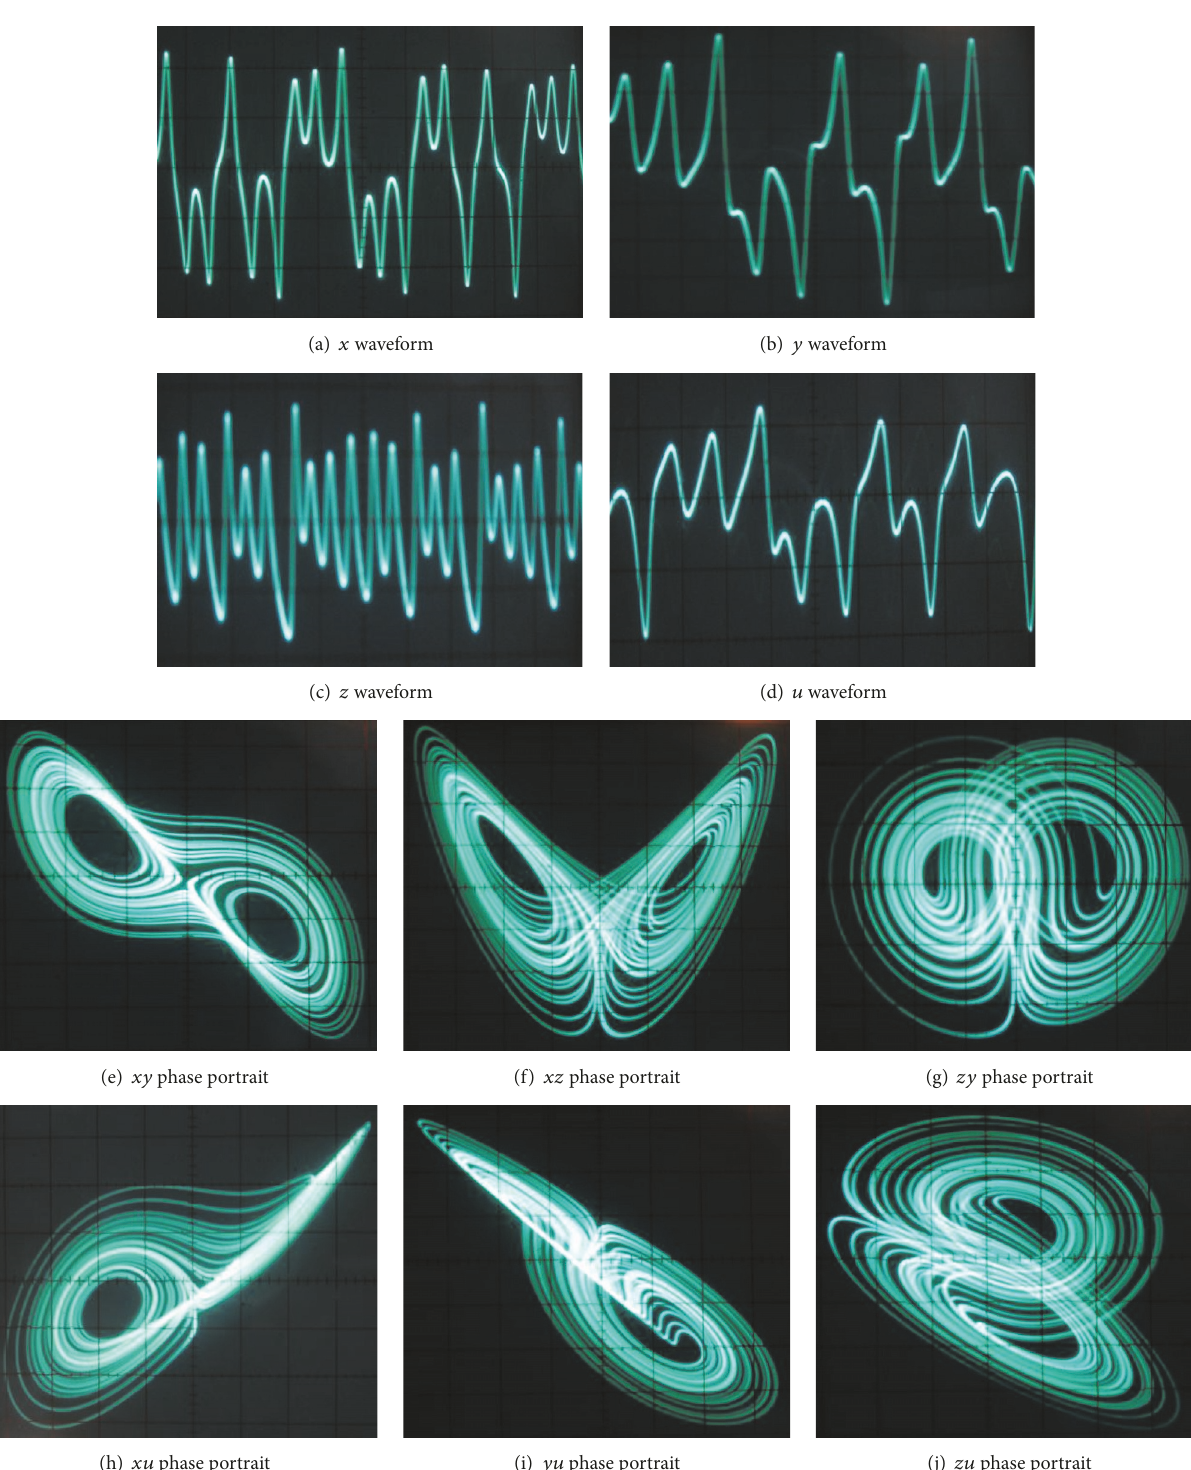
Figure 27: The output waveforms and phase portraits signal photos of the novel (𝑦 + 𝑧) - 𝑢 - 𝑥 hyperchaotic